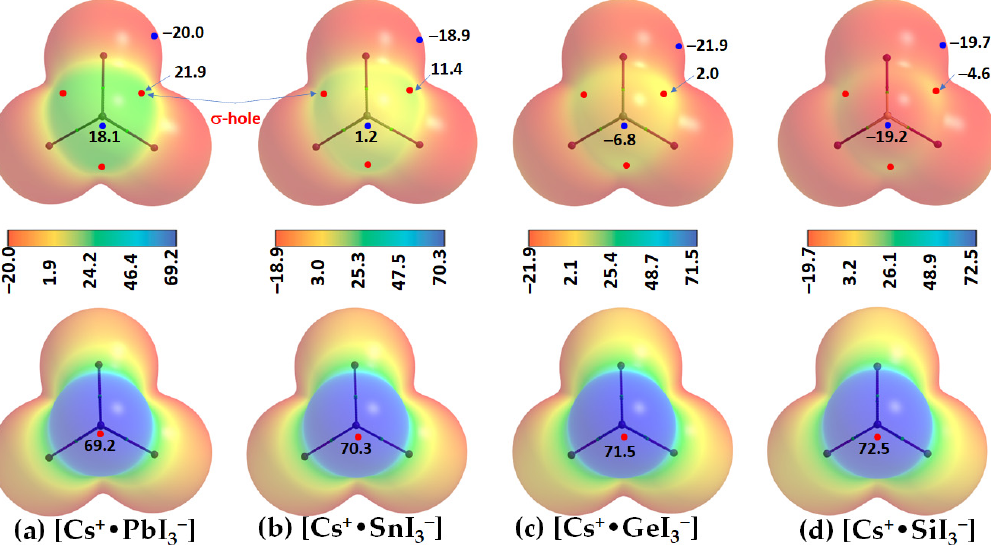
Figure 4. ( a – d ) The [ ω B97Xd/def2-TXVPPD]-level potential on the electrostatic surface of [Cs + •TtI 3 − ] (Tt = Pb, Sn, Ge, Si), mapped on their corresponding 0.001 a.u. ( electrons Bohr -3 ) isoelectronic density envelopes. The top and bottom panels represent Tt and Cs sites of each CsTtI 3 facing the reader, respectively. Selected local most maxima and minima of potential ( V S,max and V S,min ) represented by tiny circles in red and blue, respectively, are depicted. Values are given in kcal mol − 1